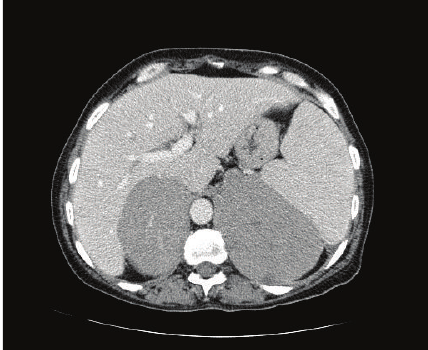
Figure 3: Spiral 64-slice CT scan obtained following intravenous contrast (100mL Iohexol) in portovenous phase demonstrates marked, homogenous bilateral adrenal gland enlargement with no evidence of disease